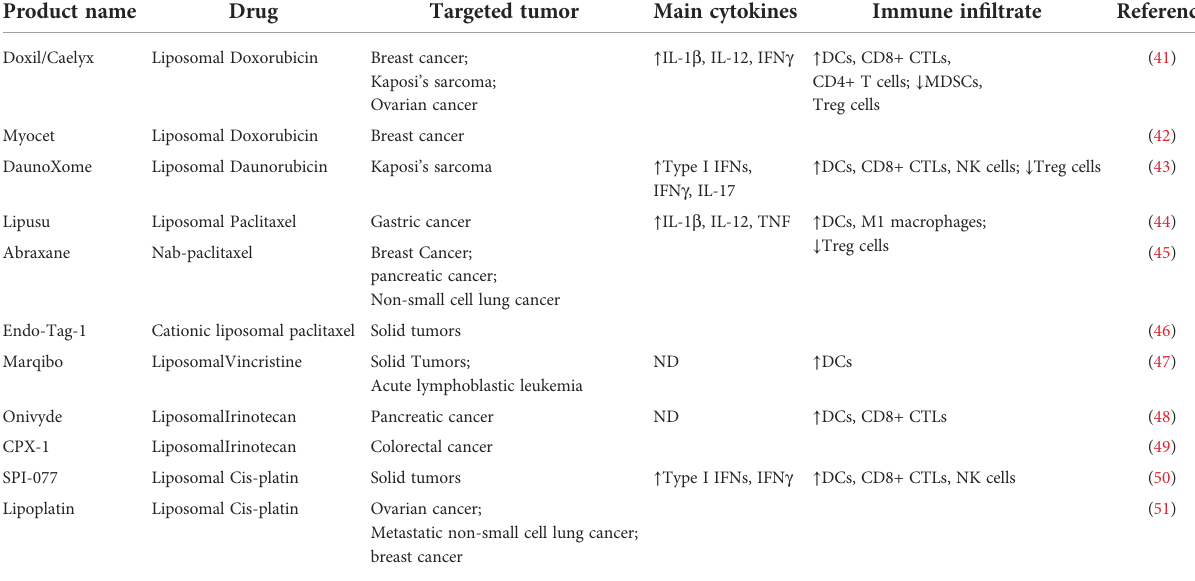
TABLE 1 Nano-chemotherapeutic Drugs approved in